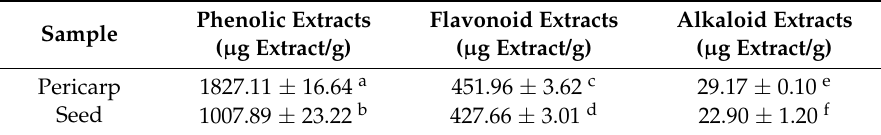
Table 3. IC 50 values of DPPH radical scavenging activities of longan byproducts.